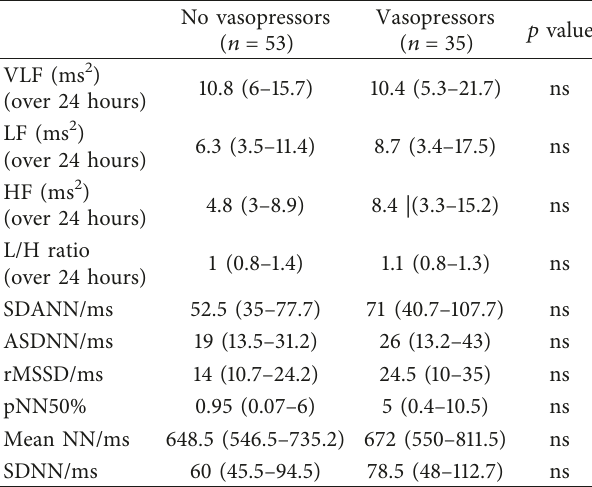
Table 2: Comparisons of heart rate variability domains between patients by vasopressor